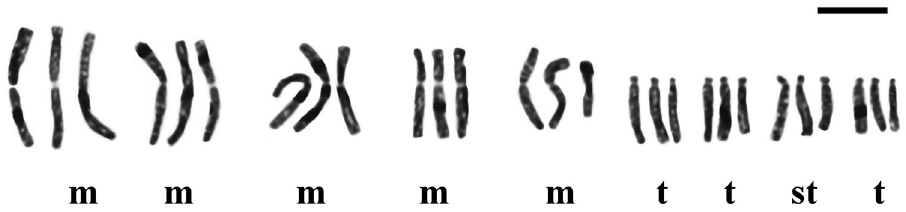
Figure 4. Karyogram of Fritillaria montana from Mt. Boutsi, 2n = 3x = 27. Bar = 10